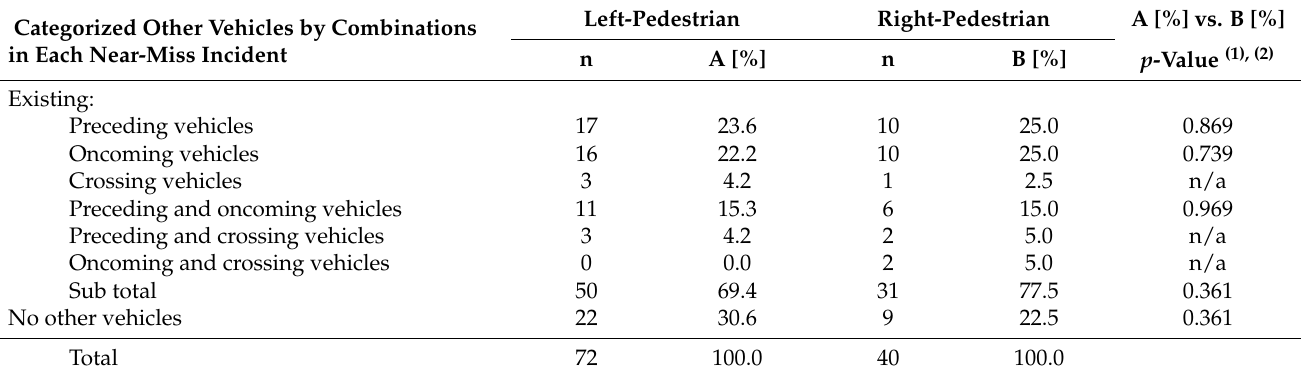
Table 5. Comparison of the distribution of near-miss incidents according to the combination of other categorized vehicles in the presence of Left-Pedestrian and